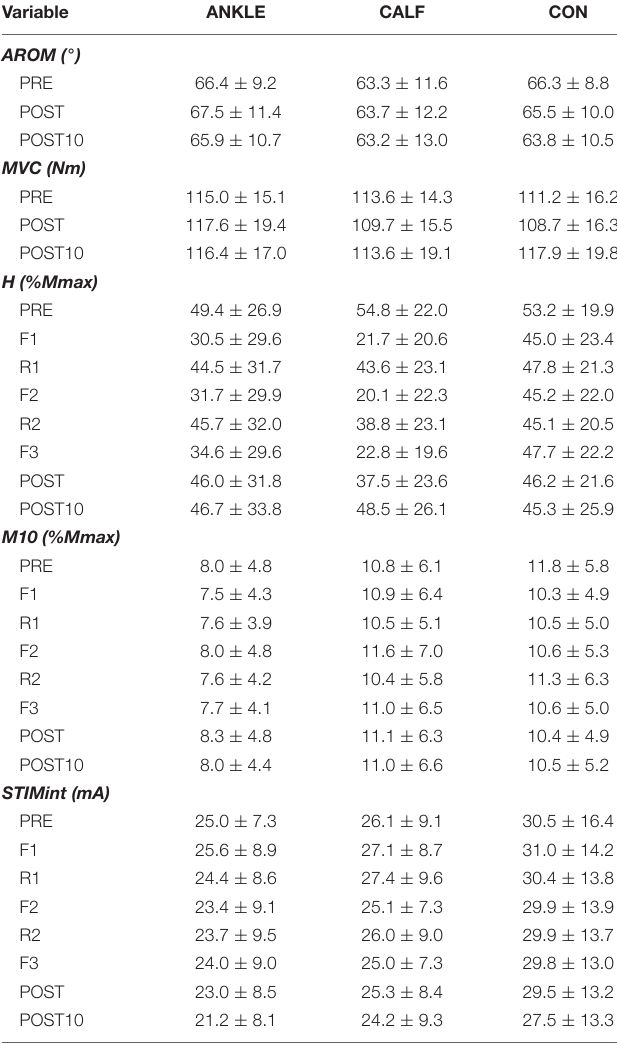
TABLE 1 | Descriptive statistics (mean ± SD). Variable